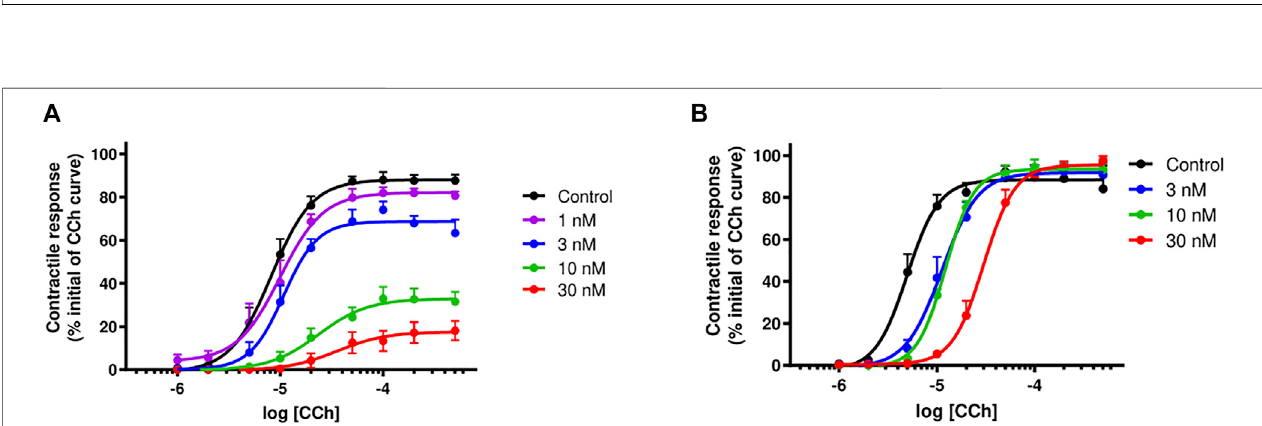
FIGURE 8 | Concentration-dependent effects of (A) α -Elapitoxin-Nn2a (1 – 30 nM; n = 5) and (B) α -Elapitoxin-Nn3a (3 – 30 nM; n = 5) on cumulative concentration- response curves to carbachol (CCh) in the unstimulated chick biventer cervicis nerve-muscle preparation.